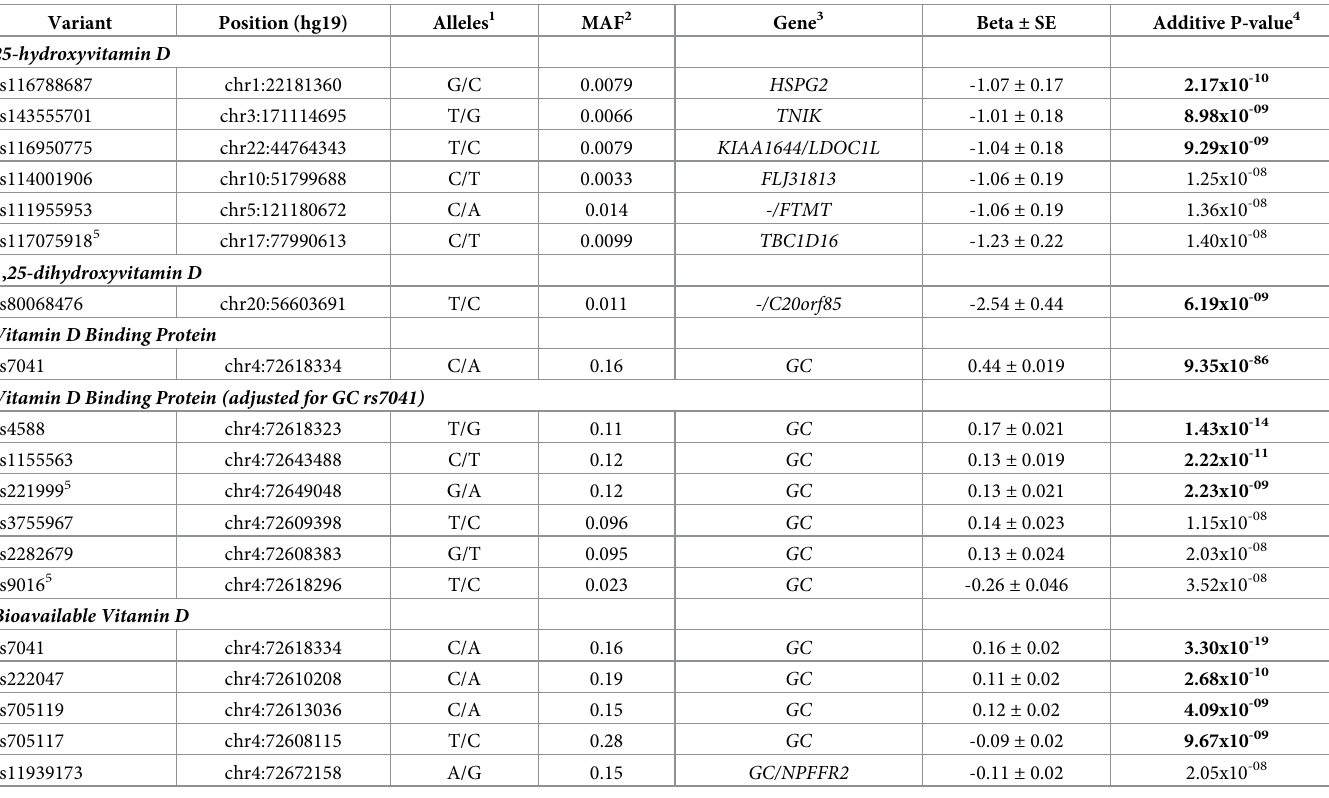
Table 2. Summary of variants associated at genome-wide significance (P < 5.0x10 -8 ) with vitamin D concentrations, parathyroid hormone concentrations, and bone mineral density in the African American-Diabetes Heart Study